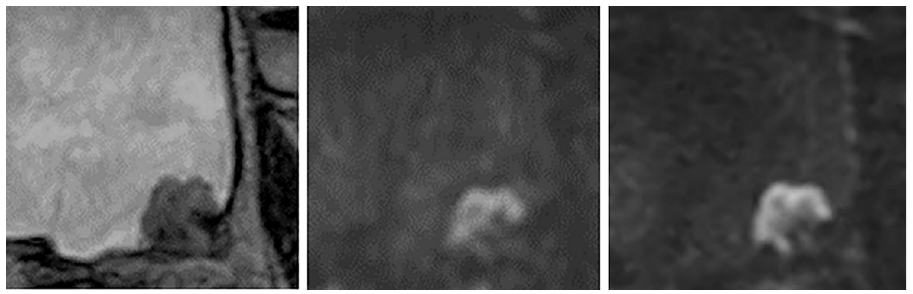
Fig 4. 61-year-old woman with the urothelial carcinoma of pTa on the posterior wall of the bladder. (A) T2WI (B) fFOV DWI (C) Zoomed DWI. VI-RADS score was 3 for reader 1 and 2 for reader 2 with fFOV DWI. In contrast, the tumor stalk clearly appeared on Zoomed DWI, and VI-RADS score was 2 for both readers.